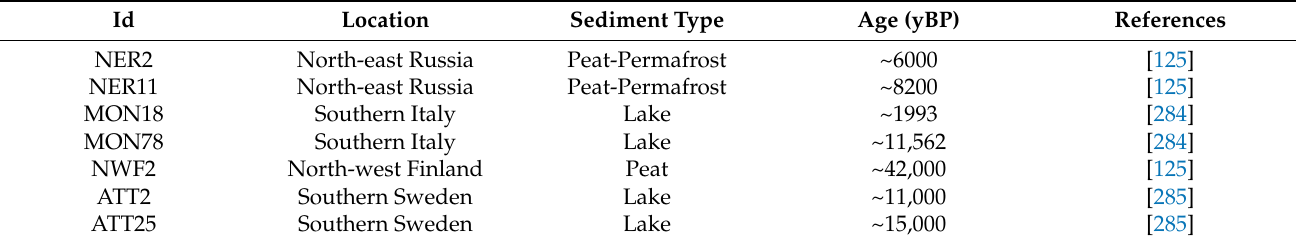
Table A6. Overview of the sediment sample used in this work.